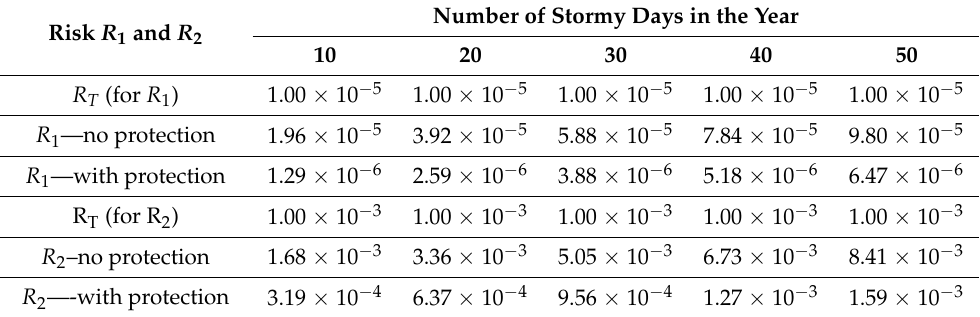
Table 7. Risk of loss of human life ( R 1 ) and risk of loss of service to the public ( R 2 ) for the different numbers of stormy days in the year.